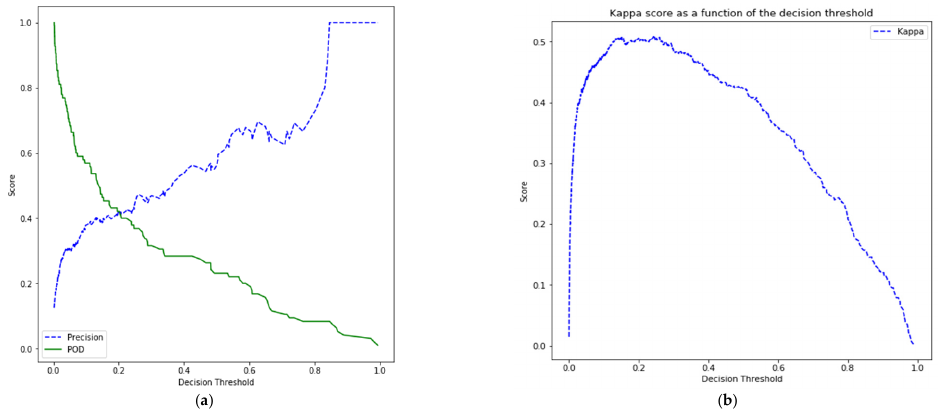
Figure 5. ( a ) Precision and POD scores vs. decision threshold, and ( b ) kappa score vs. decision threshold.